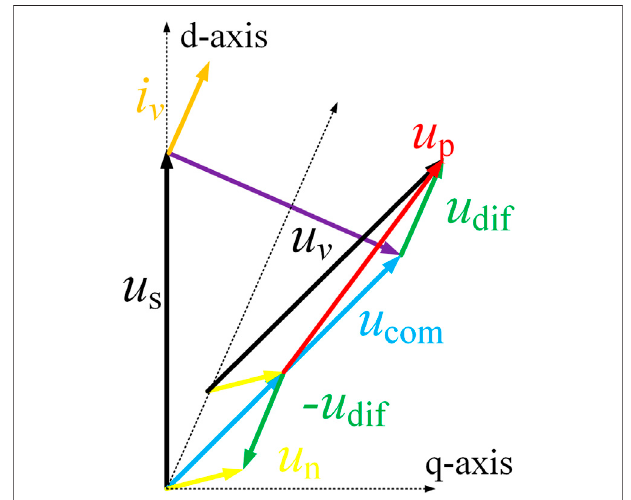
FIGURE 7 | Phasor diagram of the I-M 2 C AC